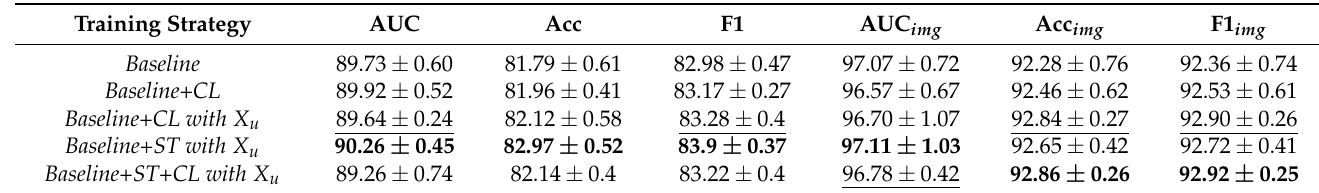
Table 4. Model performance on the in-house dataset with different training